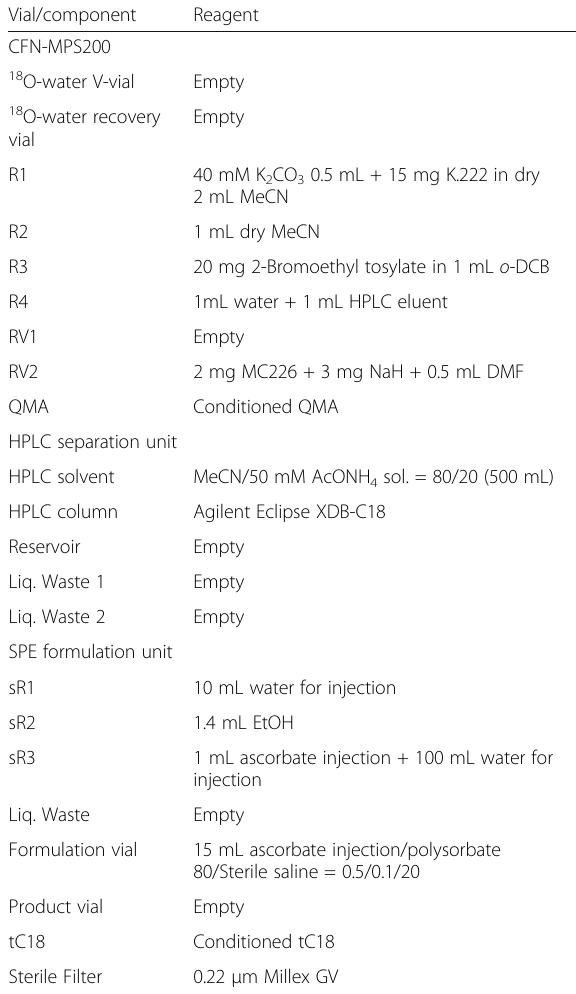
Table 1 Details of module set-up for automated [ 18 F]MC225 production with a CFN-MPS200 multipurpose synthesizer Vial/component